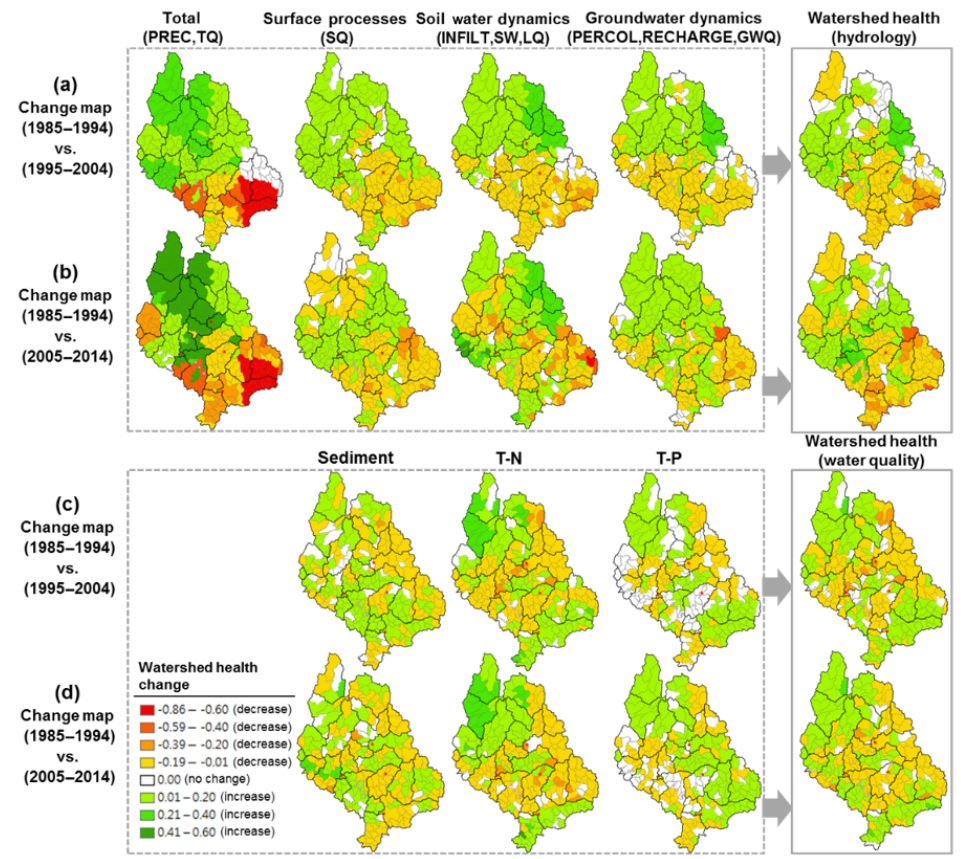
Figure 10. Watershed-health index score changes for the hydrologic (a, b) and water-quality (c, d) conditions during the period